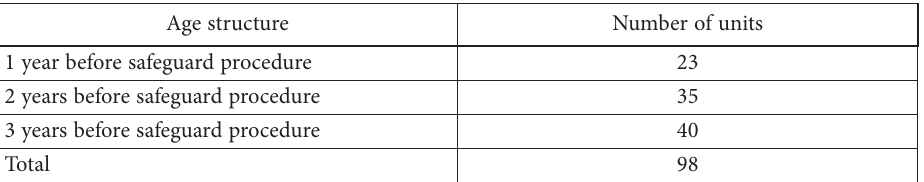
Table 1. Age structure of the sample (source: authors based on Bisnode Magnusweb) Age